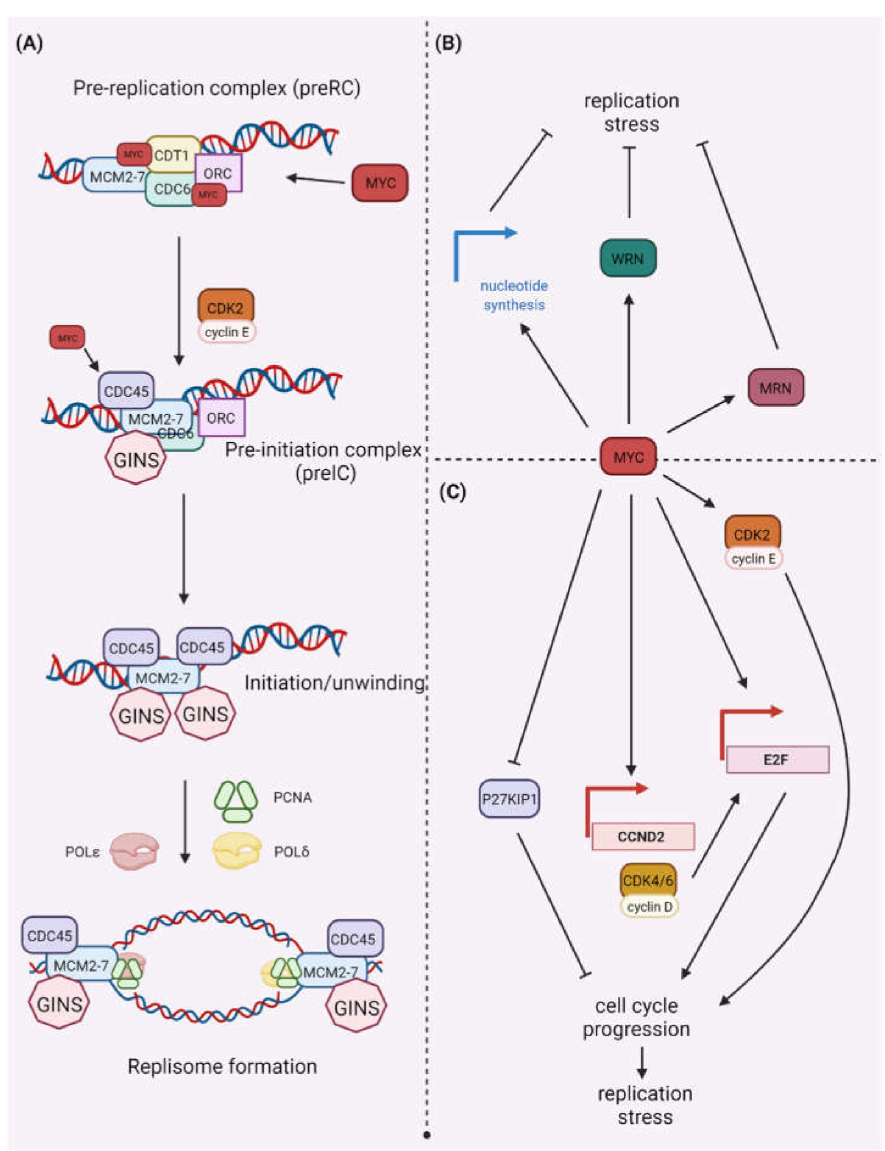
Figure 1. MYC’s role in ( A ) replication and ( B , C ) replication stress. ( A ) The origin recognition complex (ORC) binds to the replication origin site and recruits the DNA replication factor Cdt1 (CDT1) and the cell division control protein 6 homolog (CDC6), which aid in the loading of the DNA replication licensing factor (MCM2-7) helicases to form the pre-replicative complex (pre-RC). The pre-RC is phosphorylated by CDK2 and protein DBF4 homolog A/B (DBF4/DRF1)-dependent cell division cycle 7-related protein kinase (CDC7), permitting recruitment of cell division control protein 45 homolog (CDC45) and the DNA replication complex GINS. During origin